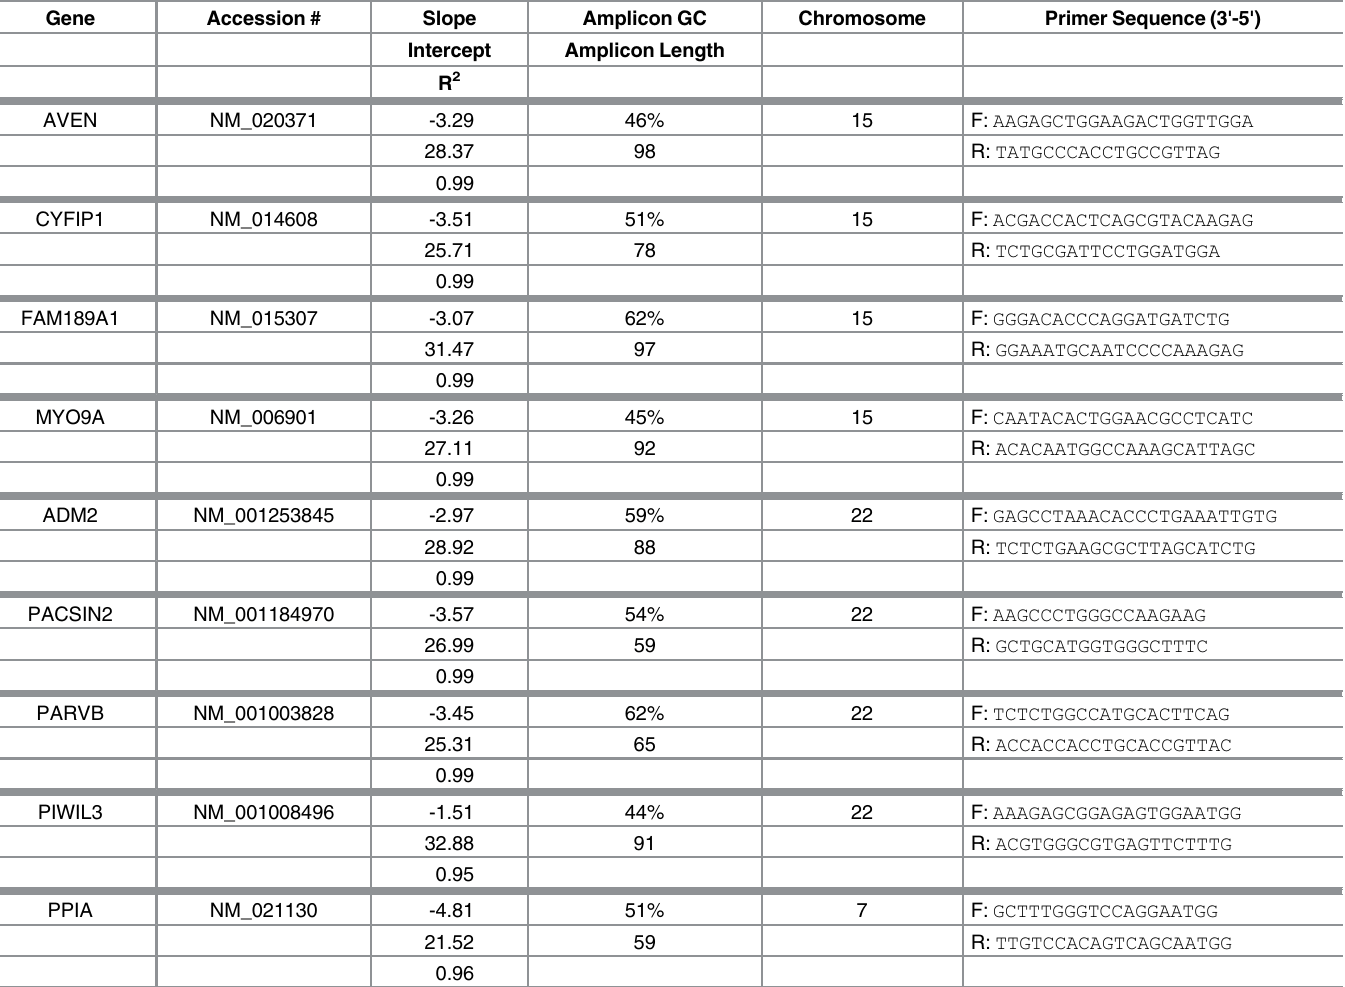
Table 1. Primer information and qPCR efficiencies for chromosomes 15, 22, and housekeeping genes.